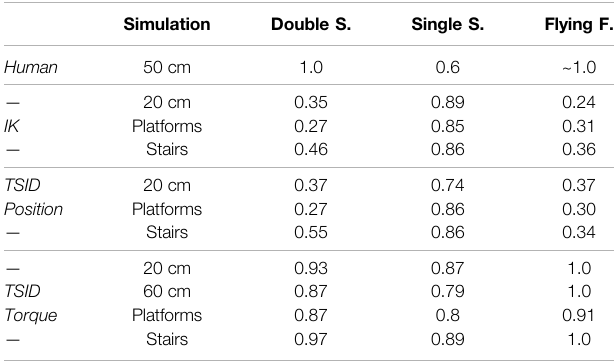
TABLE 5 | ZMP error of the stair simulation. Control scheme